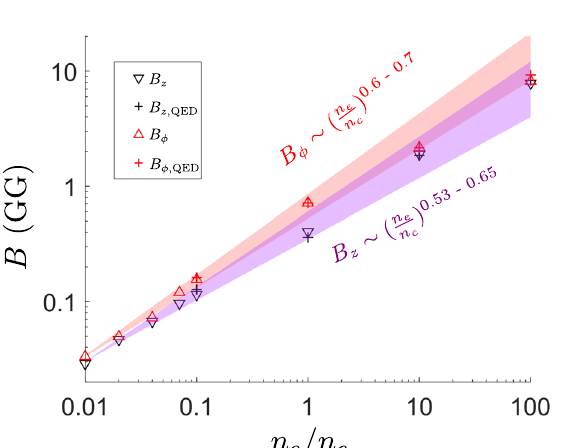
200 . Magnetic field =